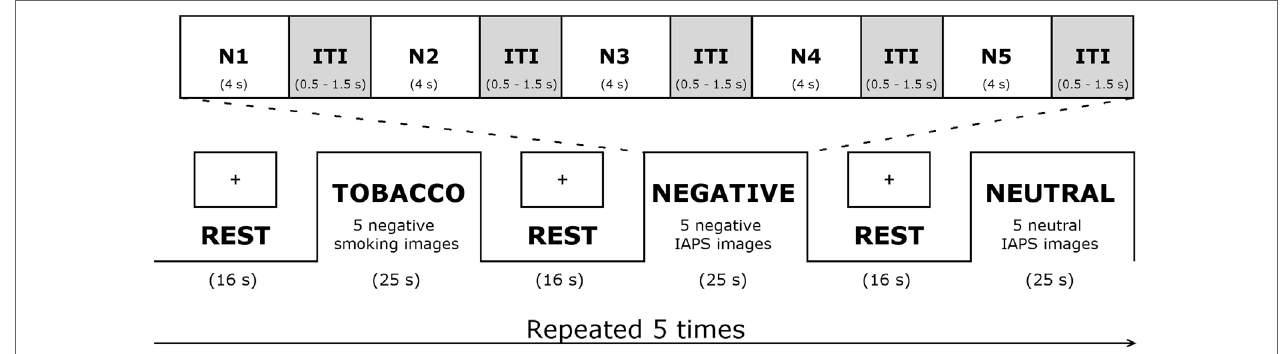
FigUre 1 | Functional magnetic resonance imaging task. Abbreviations: IAPS, International Affective Picture System; ITI, inter-stimulus interval; N1–5, 5 negative